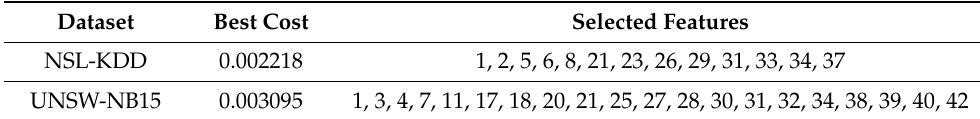
Table 1. Results analysis of OMLIDS-PBIoT based FS on applied dataset.